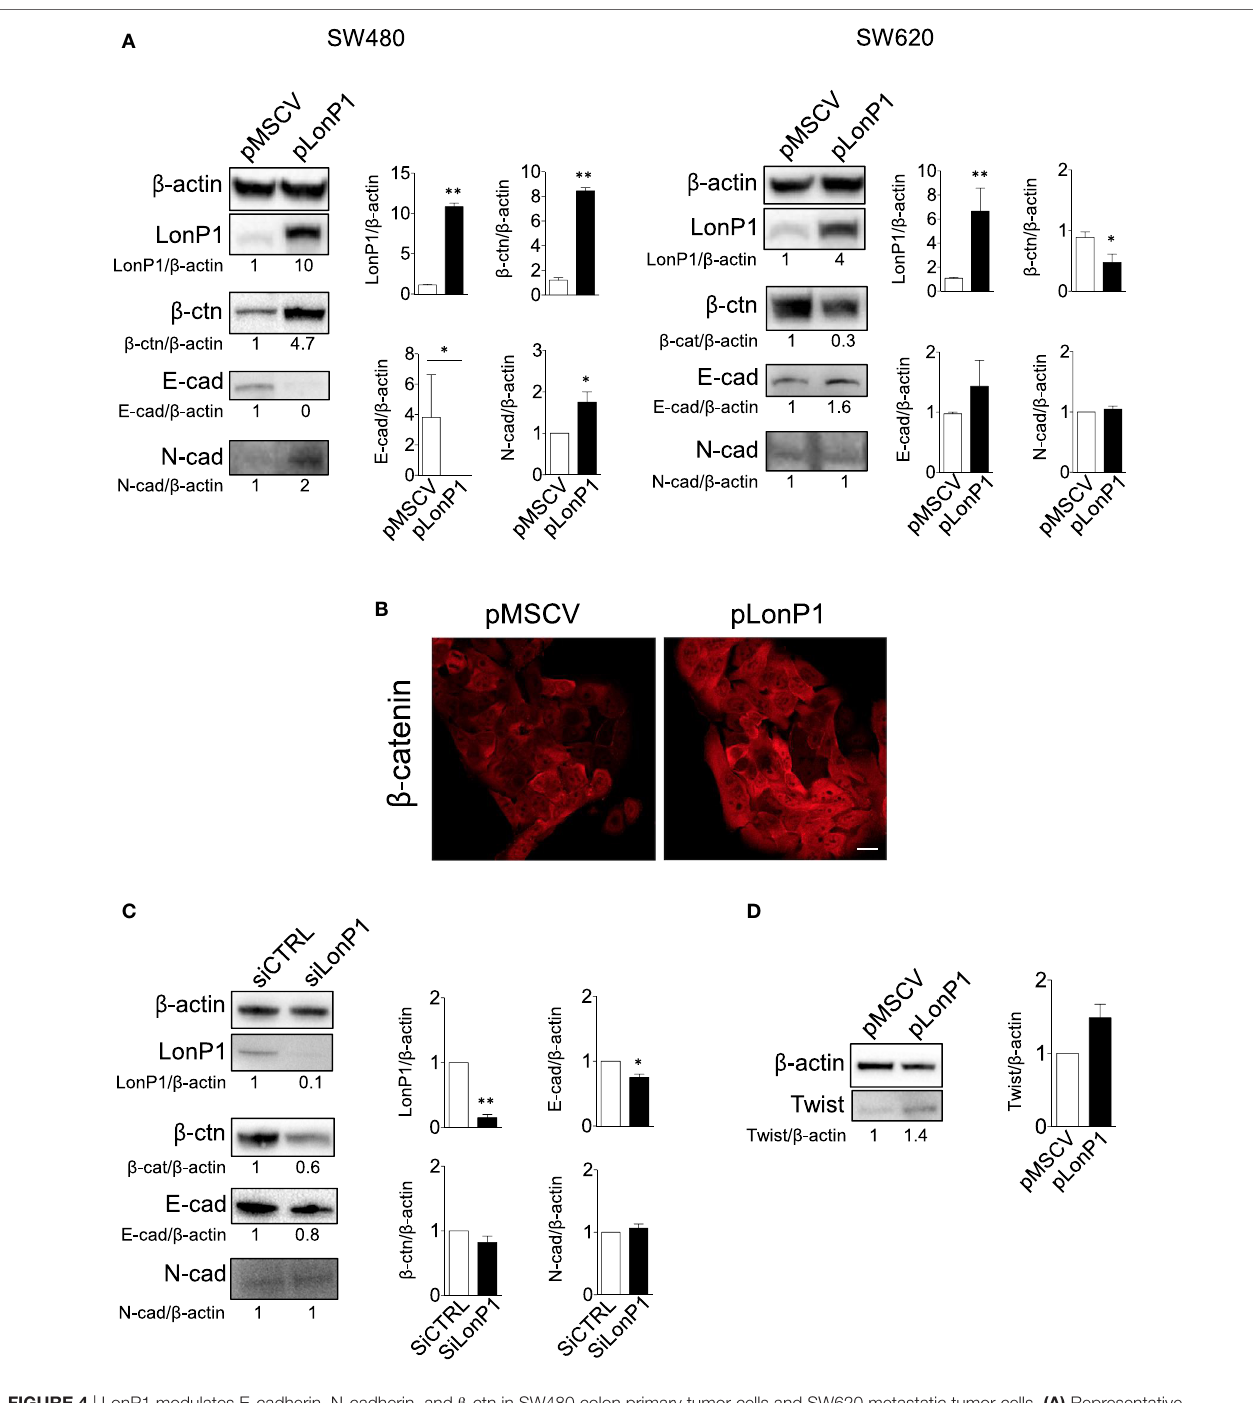
FigUre 4 | LonP1 modulates E-cadherin, N-cadherin, and β -ctn in SW480 colon primary tumor cells and SW620 metastatic tumor cells. (a) Representative Western blot analysis and relative protein level of LonP1, β -catenin ( β -ctn), E-cadherin (E-cad), N-cadherin (N-cad) in SW480 and SW620 cells overexpressing LonP1 (namely pLonP1) and in control cells, i.e., cells stably transfected with empty vector (namely pMSCV). β -actin was used as loading control. Densitometries are reported in histograms, and data are reported as mean ± SD ( n = 3). * P < 0.05 and ** P < 0.01. (B) Representative confocal microscopy image showing β -ctn localization in SW480-pMSCV and SW480-pLonP1 cells. Bar, 10 μ m. (c) Representative Western blot analysis and relative protein level of LonP1, β -ctn, and E-cad SW620, where LonP1 has been downregulated by using small interfering RNAs (siRNAs) against LonP1 mRNA (siLonP1). Control cells were transfected with scramble siRNAs and are indicated as siCTRL. Densitometries are reported in histograms, and data are reported as mean ± SD ( n = 3). * P < 0.05 and ** P < 0.01. (D) Representative Western blot analysis and relative protein level of Twist in SW480 cells overexpressing LonP1 (namely pLonP1) and in control cells, i.e., cells stably transfected with empty vector (namely pMSCV). β -actin was used as loading control. Densitometries are reported in histograms, and data are reported as mean ± SD ( n =